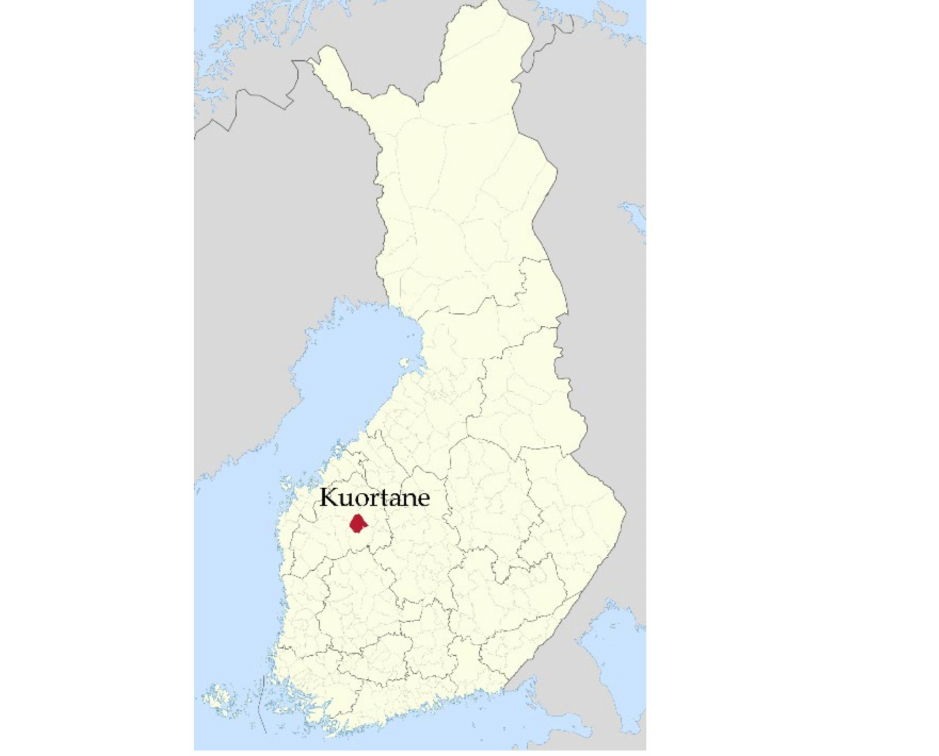
Figure 9. Kuortane, Finland.